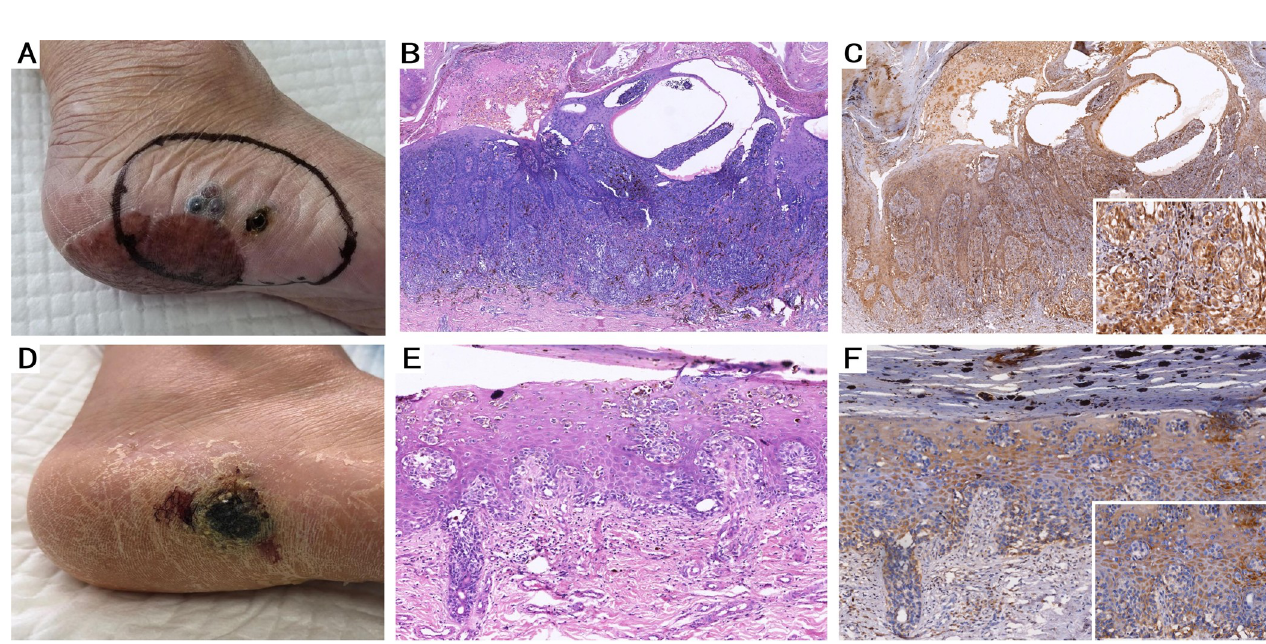
Fig 3. HSP105 expression in recurrent lesion and primary lesion. (A) Clinical picture of the ALM located in foot (recurrent lesion). (B) Histological appearance (HE, × 100) of ALM in recurrence lesion and (C) HSP 105 expression showed strong staining (IHC × 100). (D) Clinical picture of the ALM located in foot (primary lesion). (E) Histological appearance (HE, × 100) of ALM in primary lesion and (F) HSP 105 expression showed weaker staining (IHC × 100).